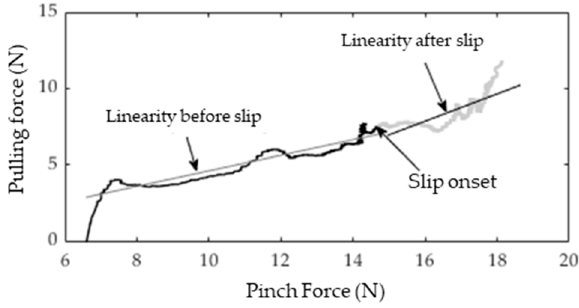
Figure 12. Pinch–pulling force relationship.